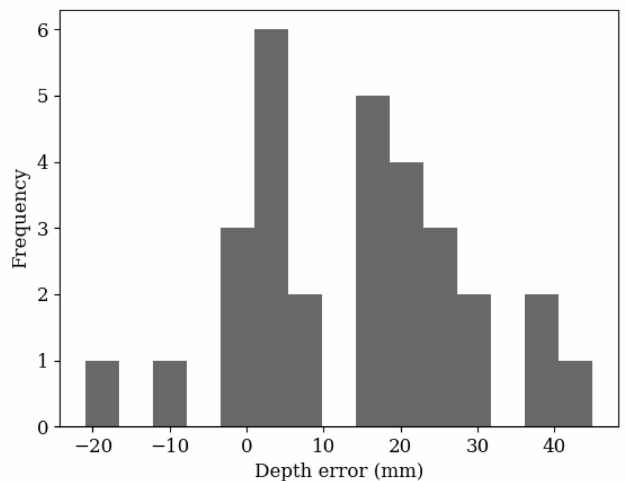
Figure 15. A histogram plot of the depth error in 30 leaf position estimations. The data shows a positively skewed bell curve, centred around 5 mm. The RMS error is 20 mm, ranging between − 20 mm and 40 mm.